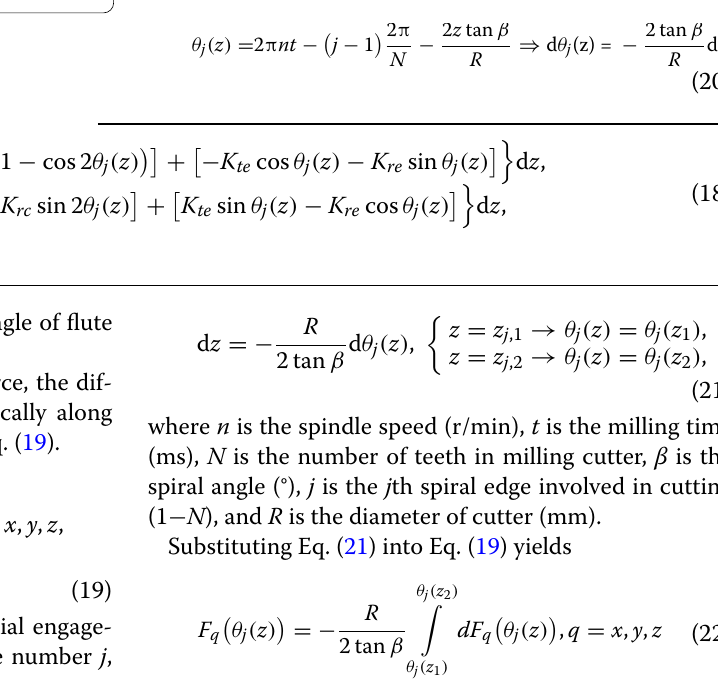
Figure 16 Geometry of cylindrical end-mill